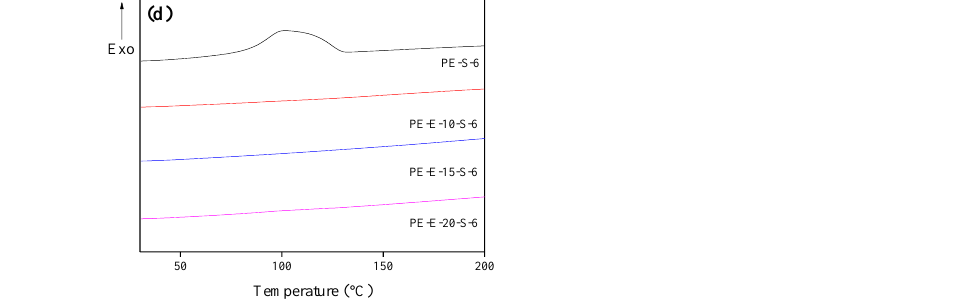
Figure 4. DSC graphs of E-beam- and sulfuric acid-treated LLDPE fibers: ( a , b ), sulfuric acid 30 min, ( c , d ), sulfuric acid 60 min.